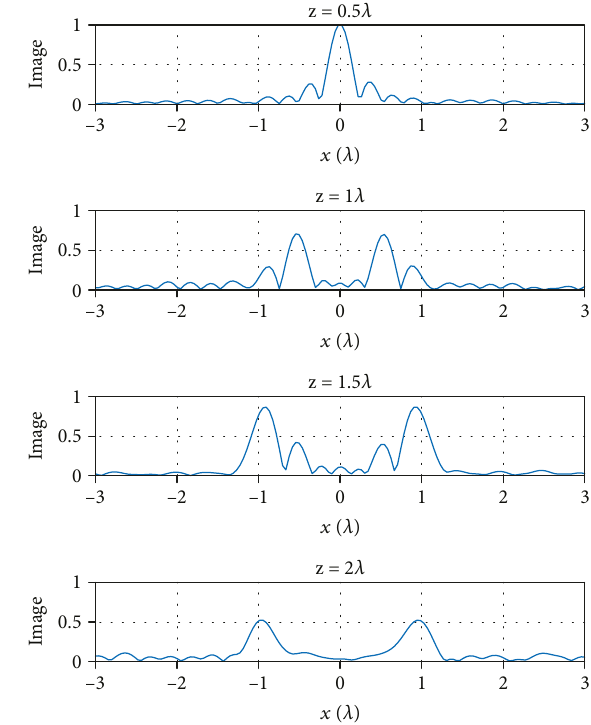
Figure 8: Reconstructed images when using 13 resonant dipole antennas. For this example, the parameters are z =0.5 λ , z = λ , 1 2 z =1.5 λ , z =2 λ , d = λ , d =2 λ , d =2 λ , s = λ /8, and D =0.25 λ . At 3 4 2 3 4 each sampling step, the 7th antenna element is excited and backscattered data is recorded by all antennas. These results are with SNR=20dB.